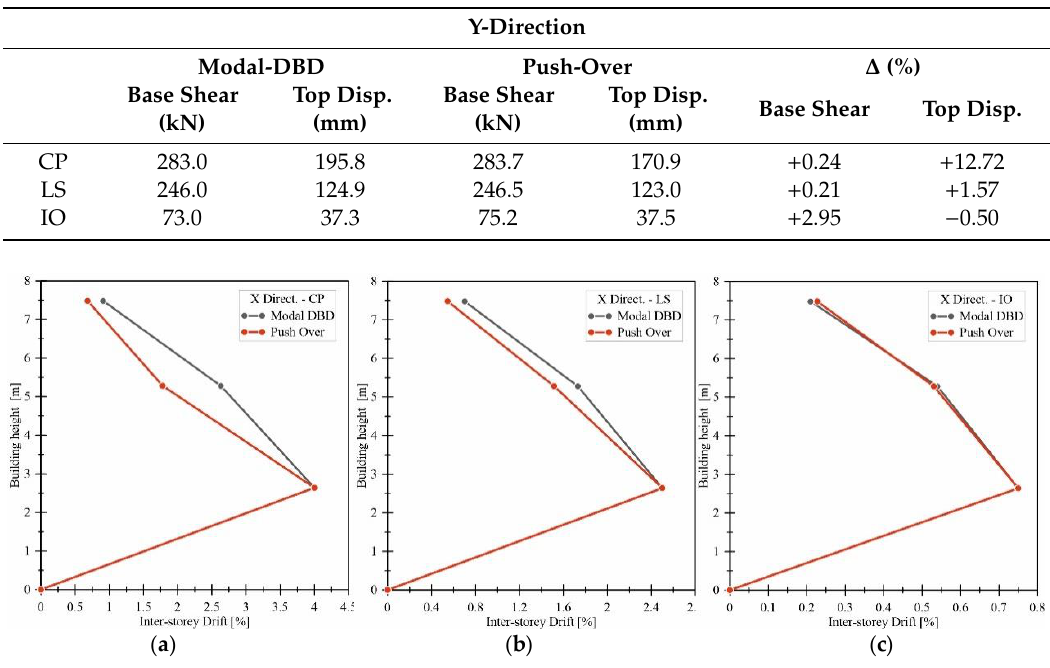
Figure 10. Comparison of inter-story displacements obtained from the Modal-DBD or the PO analyses in the X-direction ( a ) Collapse Prevention, ( b ) Life Safety and ( c ) Immediate Occupancy.